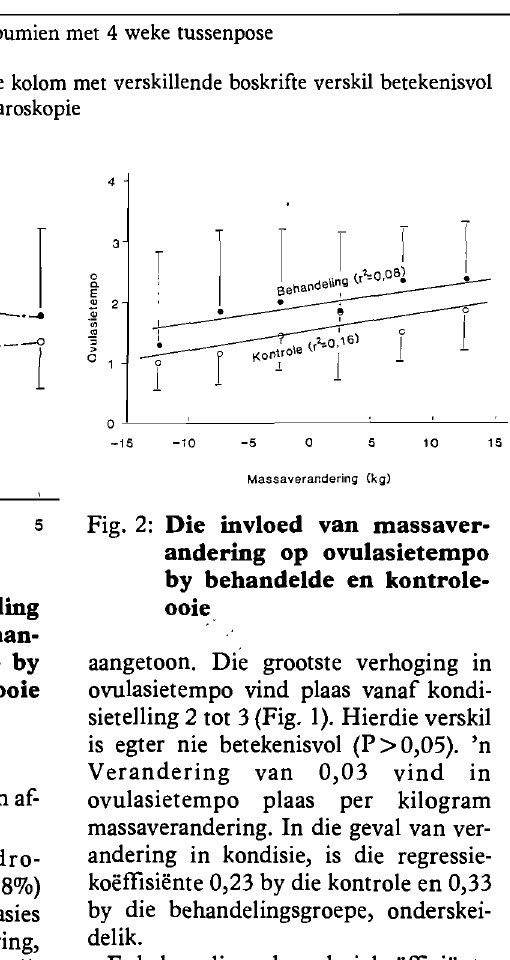
steendioon, soos in hierdie stu die ge vind, het 'n aansienlike verhoging in ovulasietempo teweeggebring.